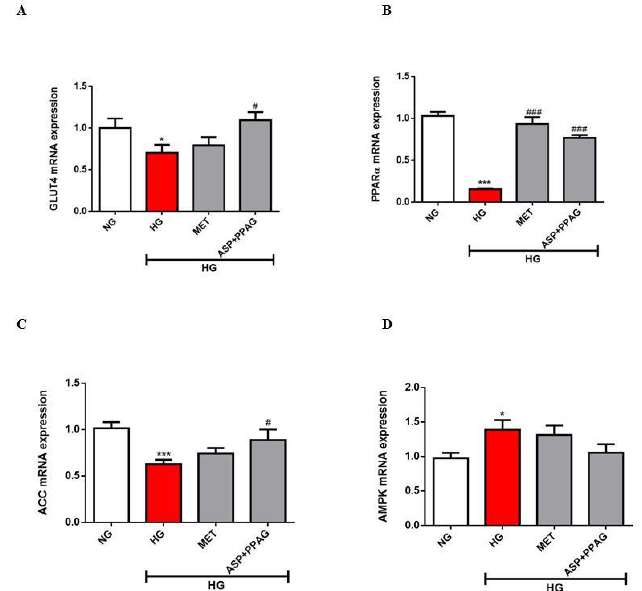
Figure 3. The combination effect of aspalathin (ASP) and phenylpyruvic acid-2- O -β- D -glucoside (PPAG) in comparison to metformin (MET) on the modulation of genes involved energy metabolism. Panels depict mRNA expression for ( A ) glucose transporter 4 (GLUT4, ( B ) peroxisome proliferator-activated receptor-alpha (PPARα), ( C ) acetyl-CoA carboxylase (ACC), and ( D ) 5’ AMP-activated protein kinase (AMPK). H9c2 cardiomyocytes were exposed to 33 mM glucose (HG) for 48 h before treatment with a combination of ASP and PPAG, as well as MET, at a dose 1 μM for 6 h. Results are expressed as the mean ± SEM of three independent experiments relative to the normal glucose (NG) (5.5 mM). * p < 0.05, *** p < 0.001 versus NG control; # p < 0.05, ### p < 0.001 versus HG control.